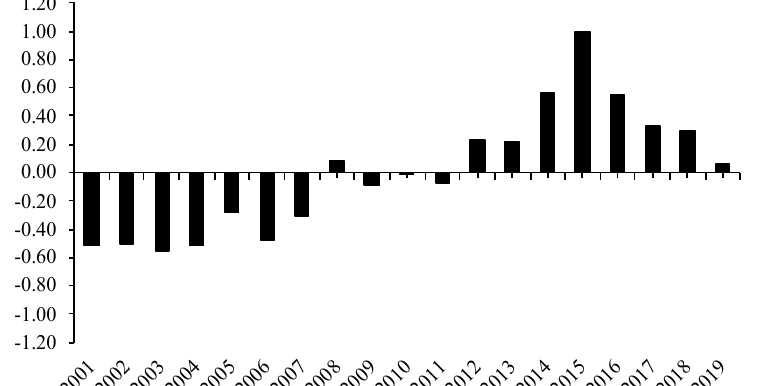
Figure 1. Comparison of imports of pastures and related turfgrass seed expressed as a proportion of the mean of the 19-year period (2698 Mt).